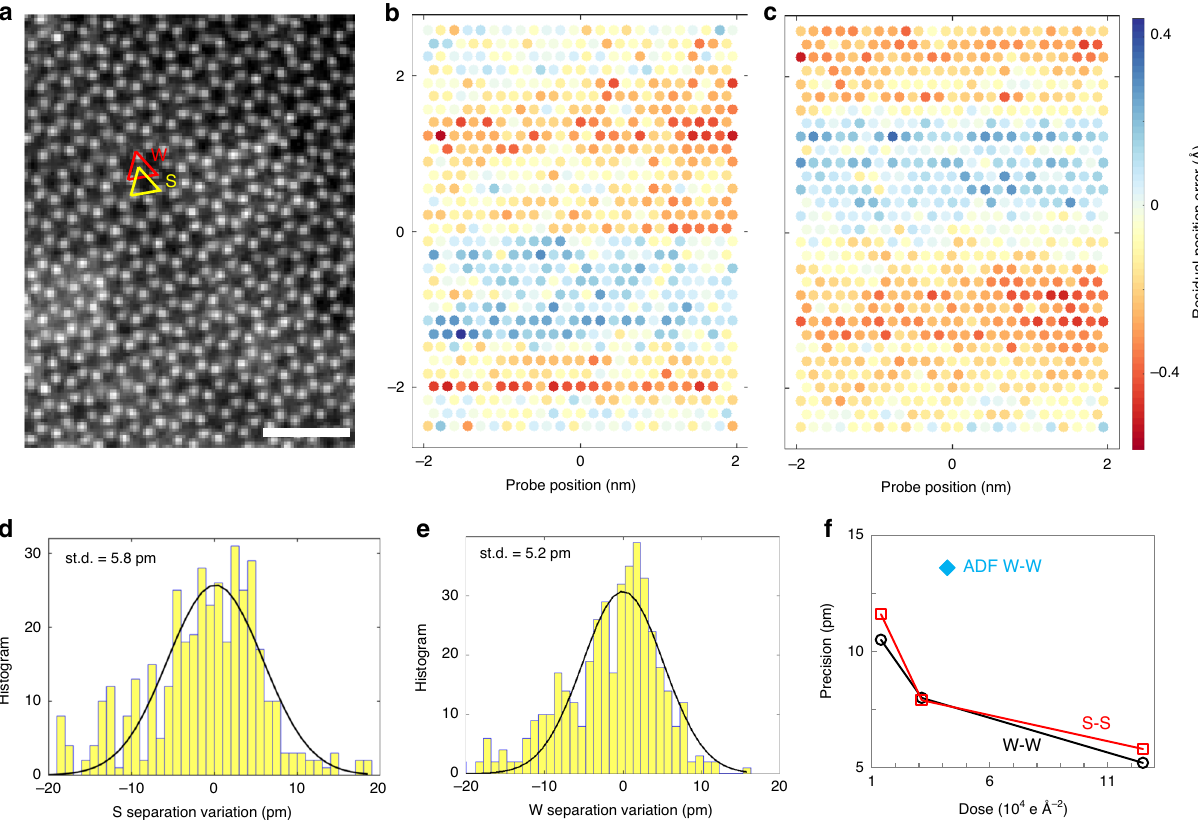
Fig. 5 Measurement precision of atomic distance. a A ptychographic reconstruction from a monolayer WS 2 sample using illumination dose of 1.25×10 5 e Å − 2 . W – W and S – S sublattices are labeled with a red and yellow triangle respectively. Scale bar is 1 nm. b , c Residual probe position errors along horizontal and vertical direction estimated by ptychography. The original probe position is shown as circles and the random position error is displayed by the false color. d , e . Statistical distribution of S – S and W – W atomic separations. f Precision of W – W and S – S distance in dependence on the illumination dose. Precision of W – W distance from a conventional ADF image with a dose 4.2 × 10 4 e Å − 2 denoted by a diamond symbol on f